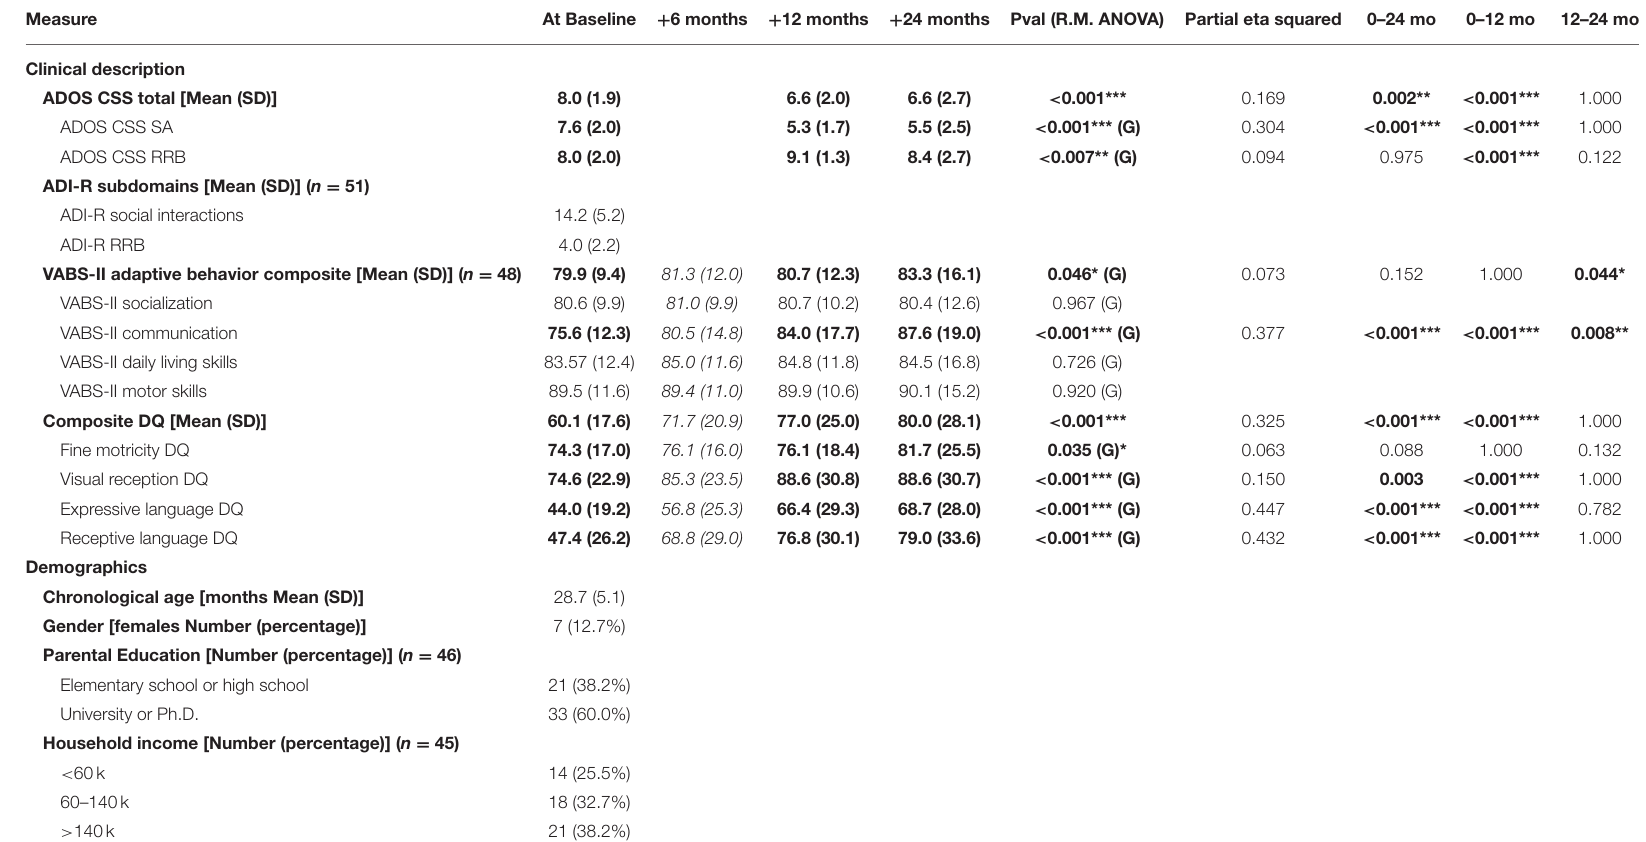
TABLE 1 | Sample characteristics over the 2 years of ESDM